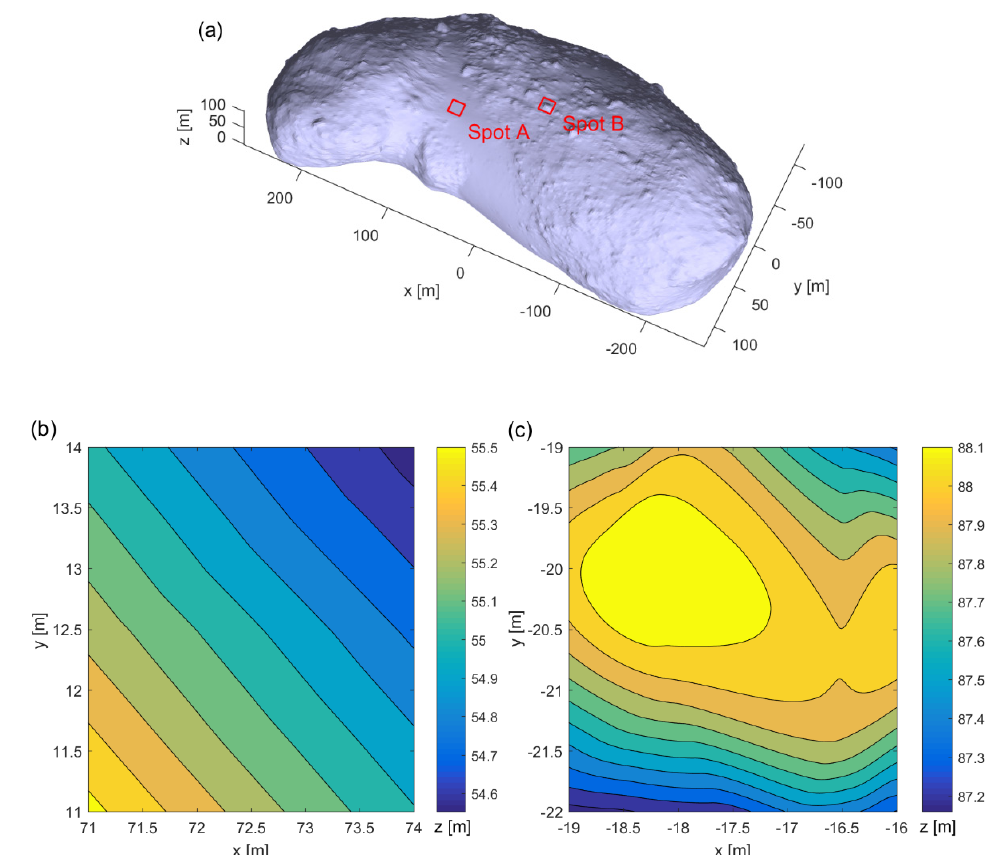
Figure 3. Two spots in the three-dimensional model of Itokawa ( a ) and topographic maps showing land contours of spot A ( b ) and spot B ( c ). The topographic map shows that the two spots are located at the slope face and small hill, respectively.